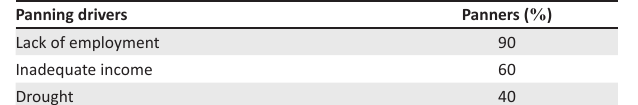
FIGURE 2: Respondents’ age profile. TABLE 1: Level of education. Schooling